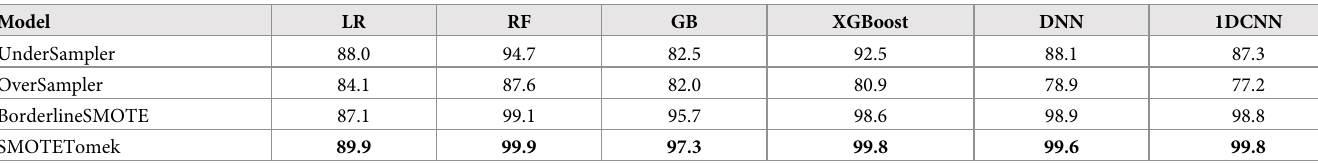
Table 8. AUC comparison results for different sampling